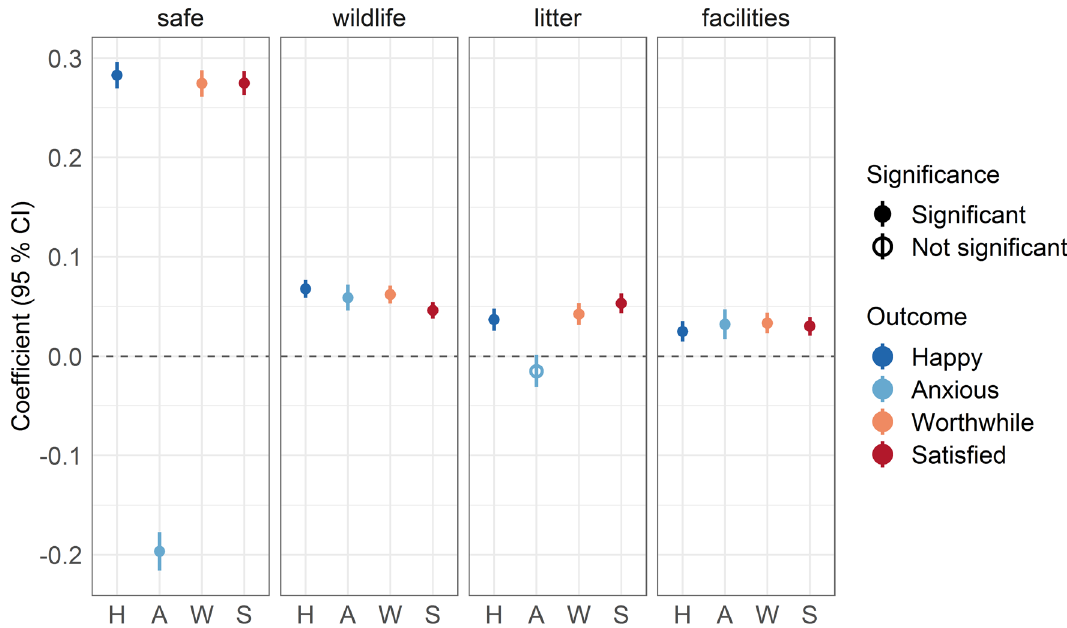
Figure 3. Well-being outcomes associated with perceived environmental qualities. Fully adjusted linear mixed effects model (Step 3) coefficients for the environmental qualities perceived safety, perceived presence of wildlife, perceived absence of litter and perceived presence of good facilities and each well-being outcome. Significance is demonstrated where the 95% CI does not cross 0 (displayed with a dashed horizontal line). Note that “H”, Happy, “A”, Anxious, “W”, Worthwhile and “S”,